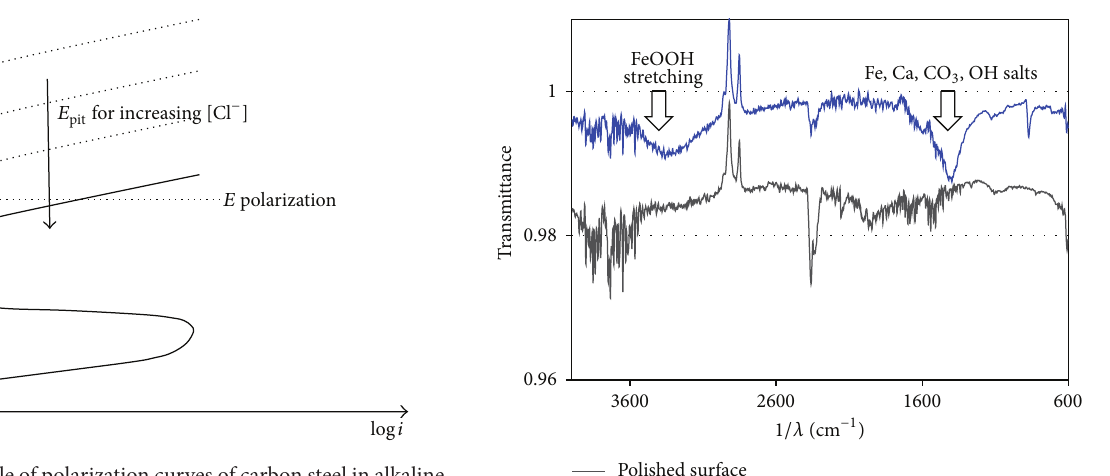
Figure 9: Example of polarization curves of carbon steel in alkaline solution as a function of chloride concentration.